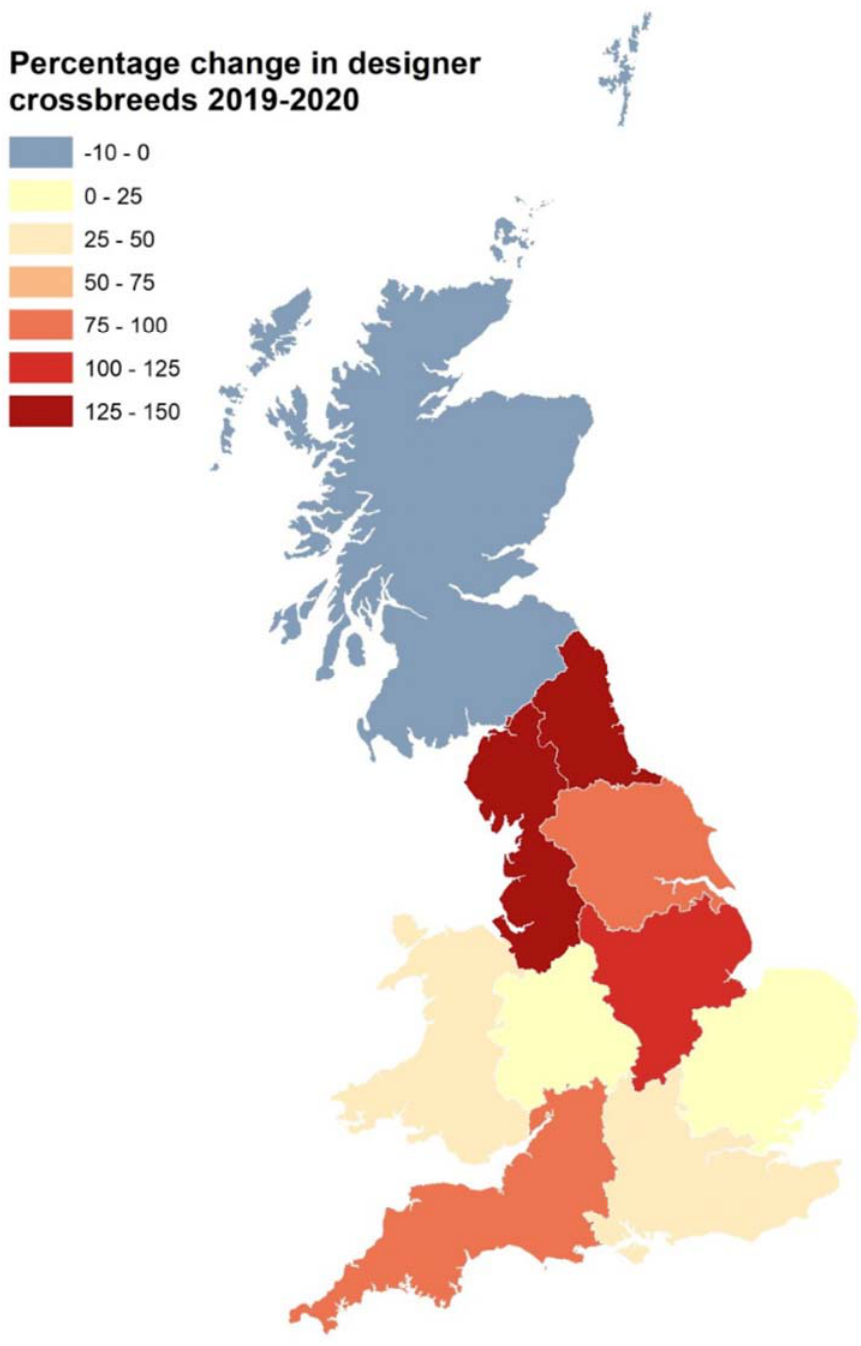
Figure 1. Spatial analysis of the percentage change in the distribution of designer crossbreeds in the Pandemic Puppy cohort ( n = 3502) relative to the 2019 puppy cohort ( n = 944). The overall sample size of designer crossbreeds in both 2019 and 2020 in Northern Ireland was too small to draw any meaningful conclusions (2019: n = 5; 2020: n = 7) and was therefore omitted from this analysis.